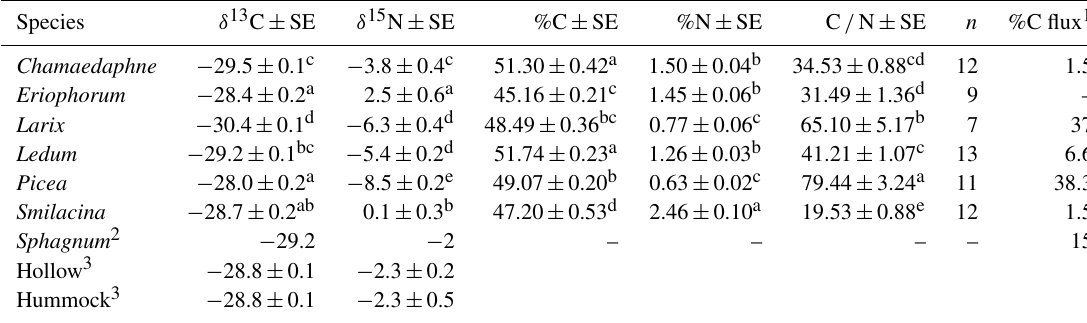
Table 2. Average foliar values for δ 13 C, δ 15 N, %C, %N, and C / N ( n = 7). Species